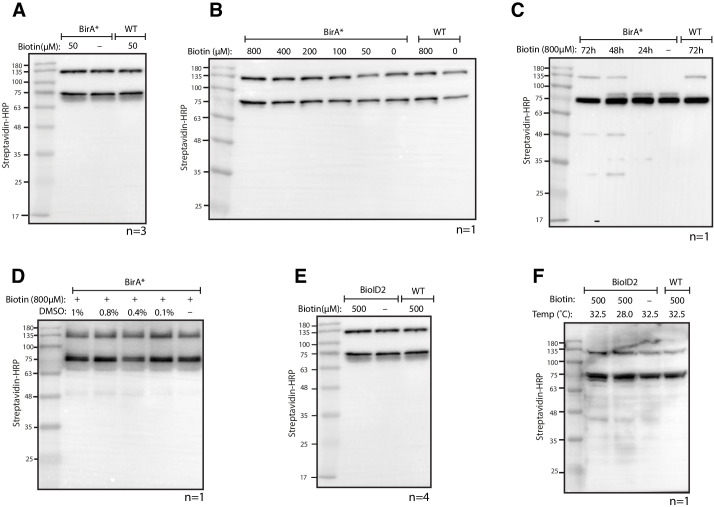
Testing BioID and BioID2 in transgenic zebrafish.(A) Streptavidin-HRP blot showing biotinylated proteins in BioID (BirA*) transgenic zebrafish embryos. Zebrafish embryos were incubated with 50 µM biotin for 18 hr prior to protein extraction and western blotting. (B, C and D) Streptavidin-HRP blots showing biotinylated proteins in zebrafish embryos with (B) increased biotin concentration, (C) increased biotin incubation time and (D) addition of DMSO. (E and F) Streptavidin-HRP blots showing biotinylated proteins in BioID2 transgenic zebrafish embryos under (E) standard incubation temperature (28°C) and (F) elevated temperature (32.5°C) during biotin incubation. Each sample is a pool of 30 embryos at 3 dpf. The two prominent protein bands present in all samples were endogenous biotinylated proteins.